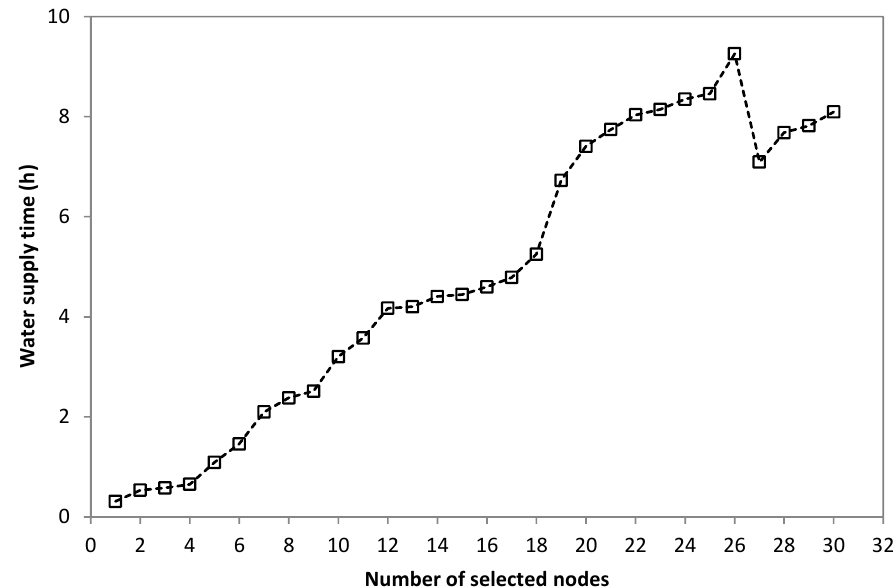
Figure 8. Variation in water supply time as a function of the selected nodes.